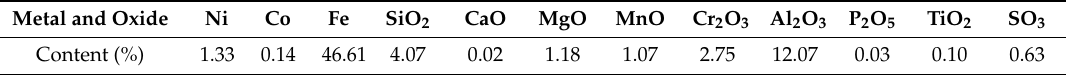
Table 1. Metal and oxide content in limonite nickel ore.